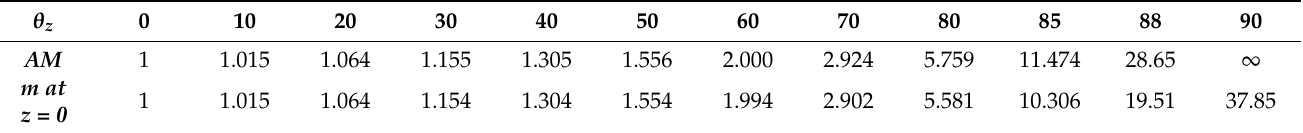
Table 1. Values of air and optical masses by Equations (3) and (5) (own study).